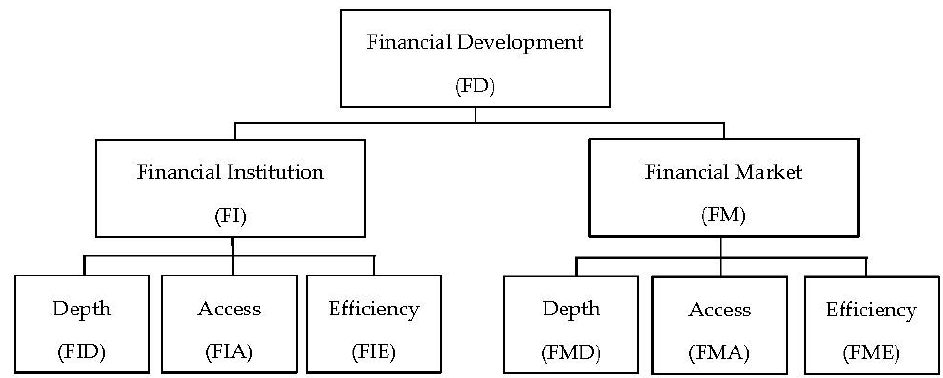
Figure 1. Index system of financial development constructed by Svirydzenka [44].